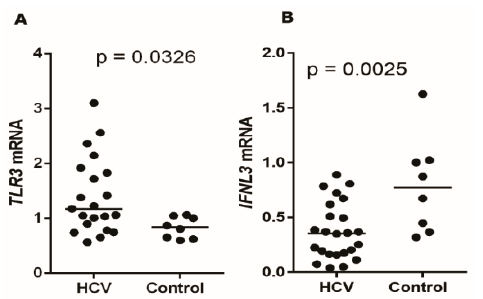
Figure 1. Median intrahepatic gene expressions of TLR3 ( A ) and IFNL3 ( B ) for groups of patients chronically infected by HCV and those of healthy controls. Median TLR3 : HCV = 1.08 and control = 0.86; median IFNL3 : HCV = 0.43 and control = 0.86. Mann–Whitney Test.